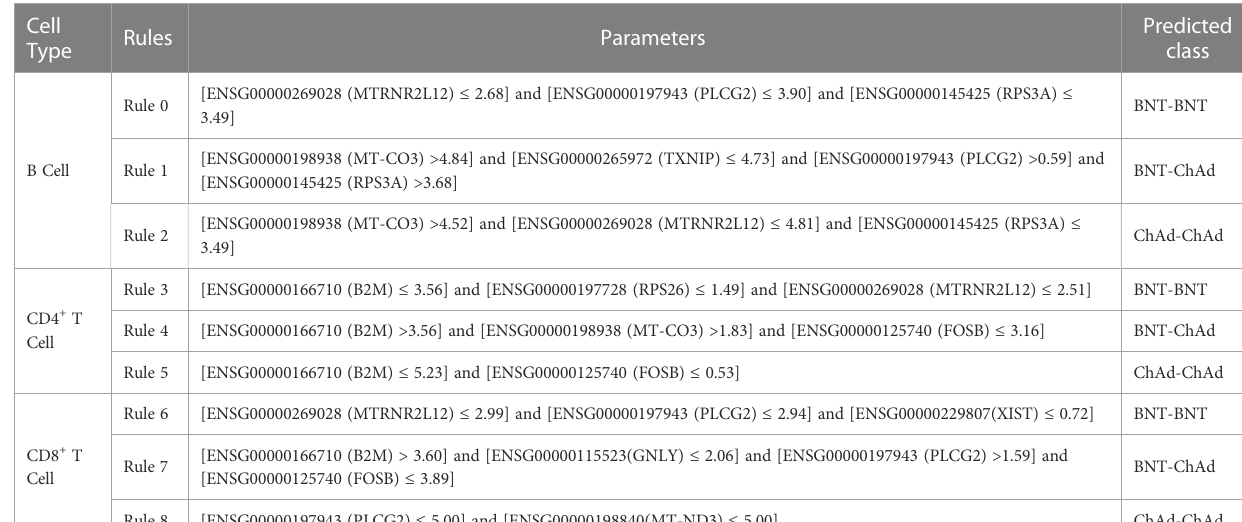
TABLE 7 Representative rules in